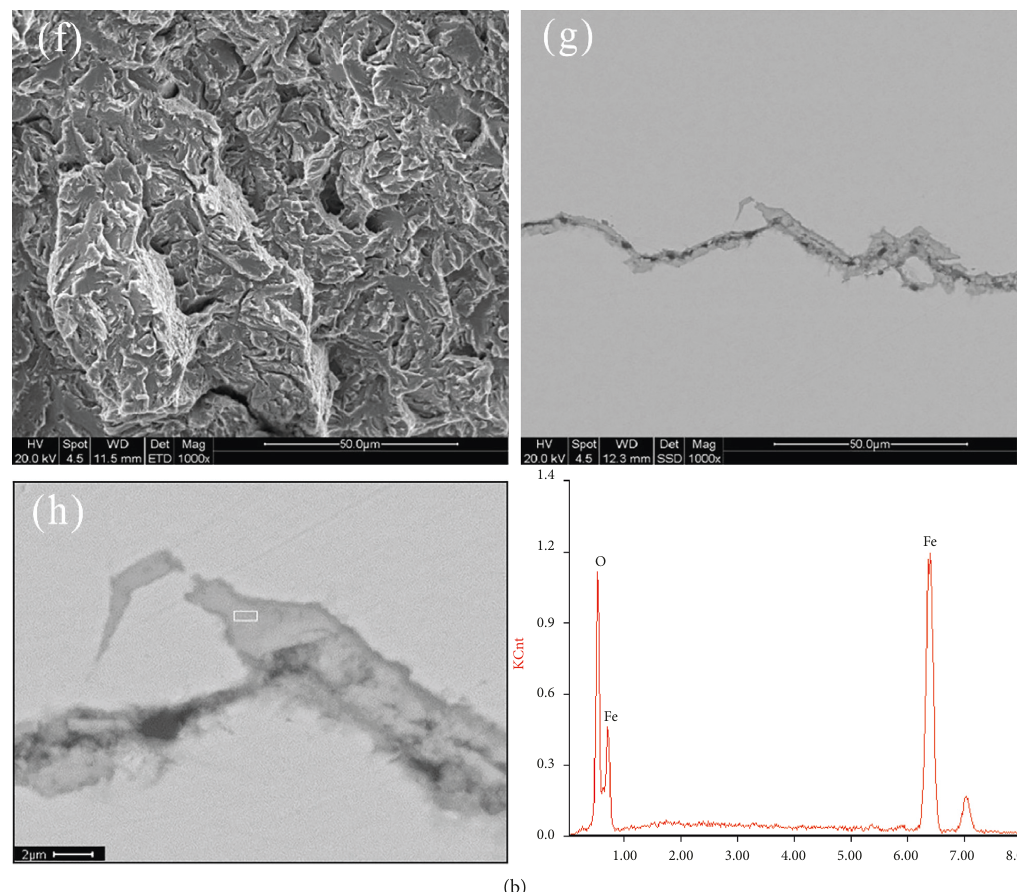
Figure 10: Scanning electron microscope analysis of Y -1. (a) The Y -1 crack. (b) Micromorphology of the crack surface. (c, h) Energy spectrum analysis. (d, e) Crack micromorphology. (f) Cleavage characteristic. (g) Local crack